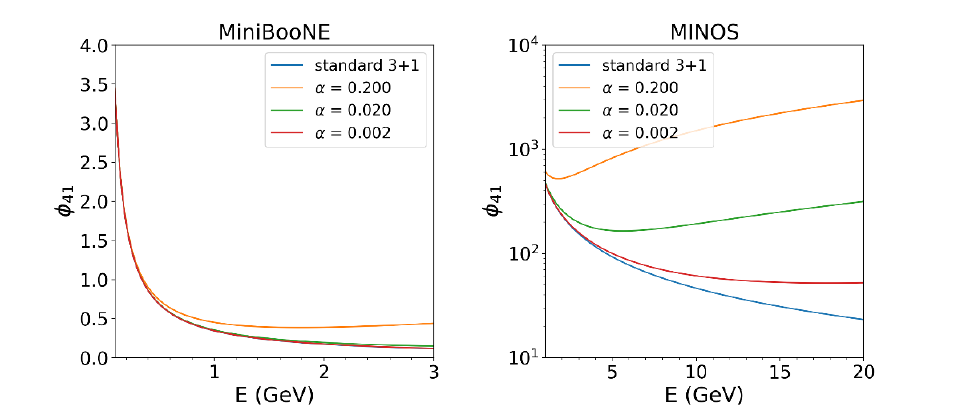
Figure 1 . The kinematic phase (cid:30) 41 as a function of the energy for MiniBooNE ( L = 0 : 541 km) and MINOS ( L = 731 km) for (cid:1) m 2 = 1 : 4 eV 2 . Di(cid:11)erent values of (cid:11) are also presented. 41